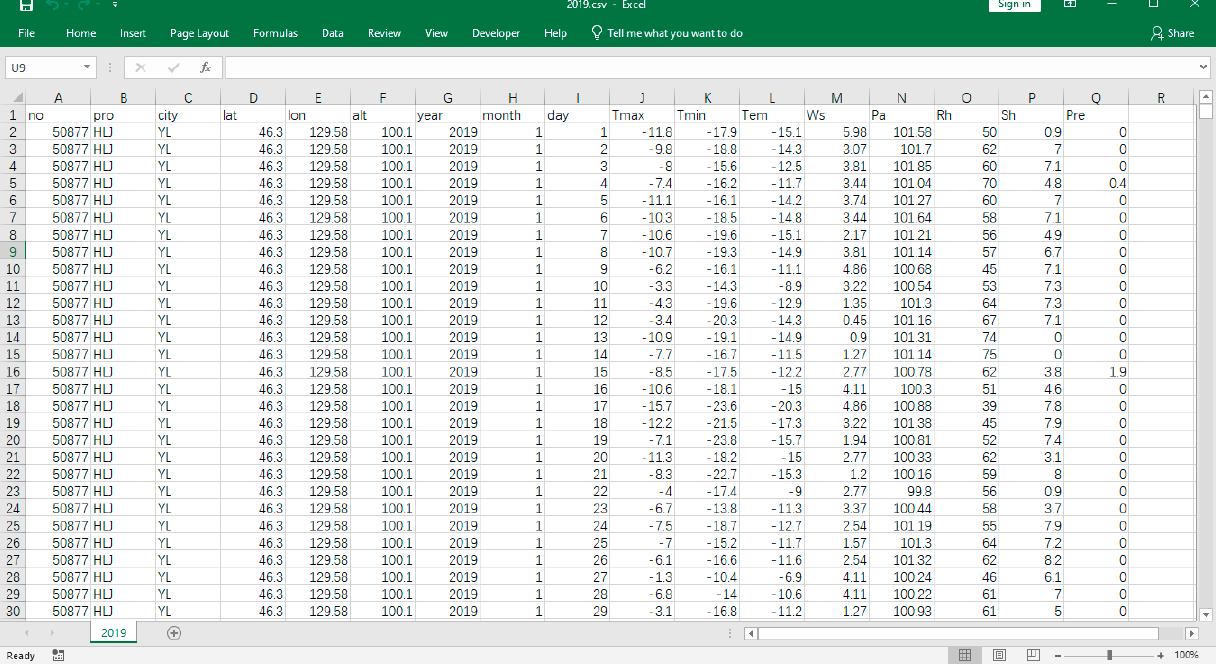
Figure 5. The example format of the meteorological data in replacement for the V3.0 data in 1Raw- Data/.